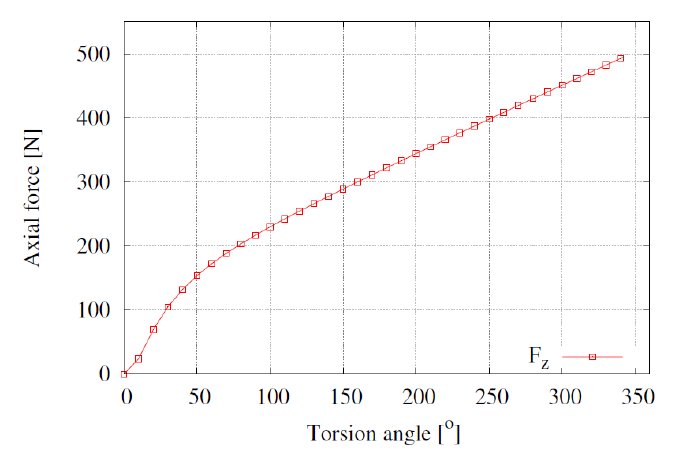
Figure 19. Numerical results for the axial compression load as a function of the torsion